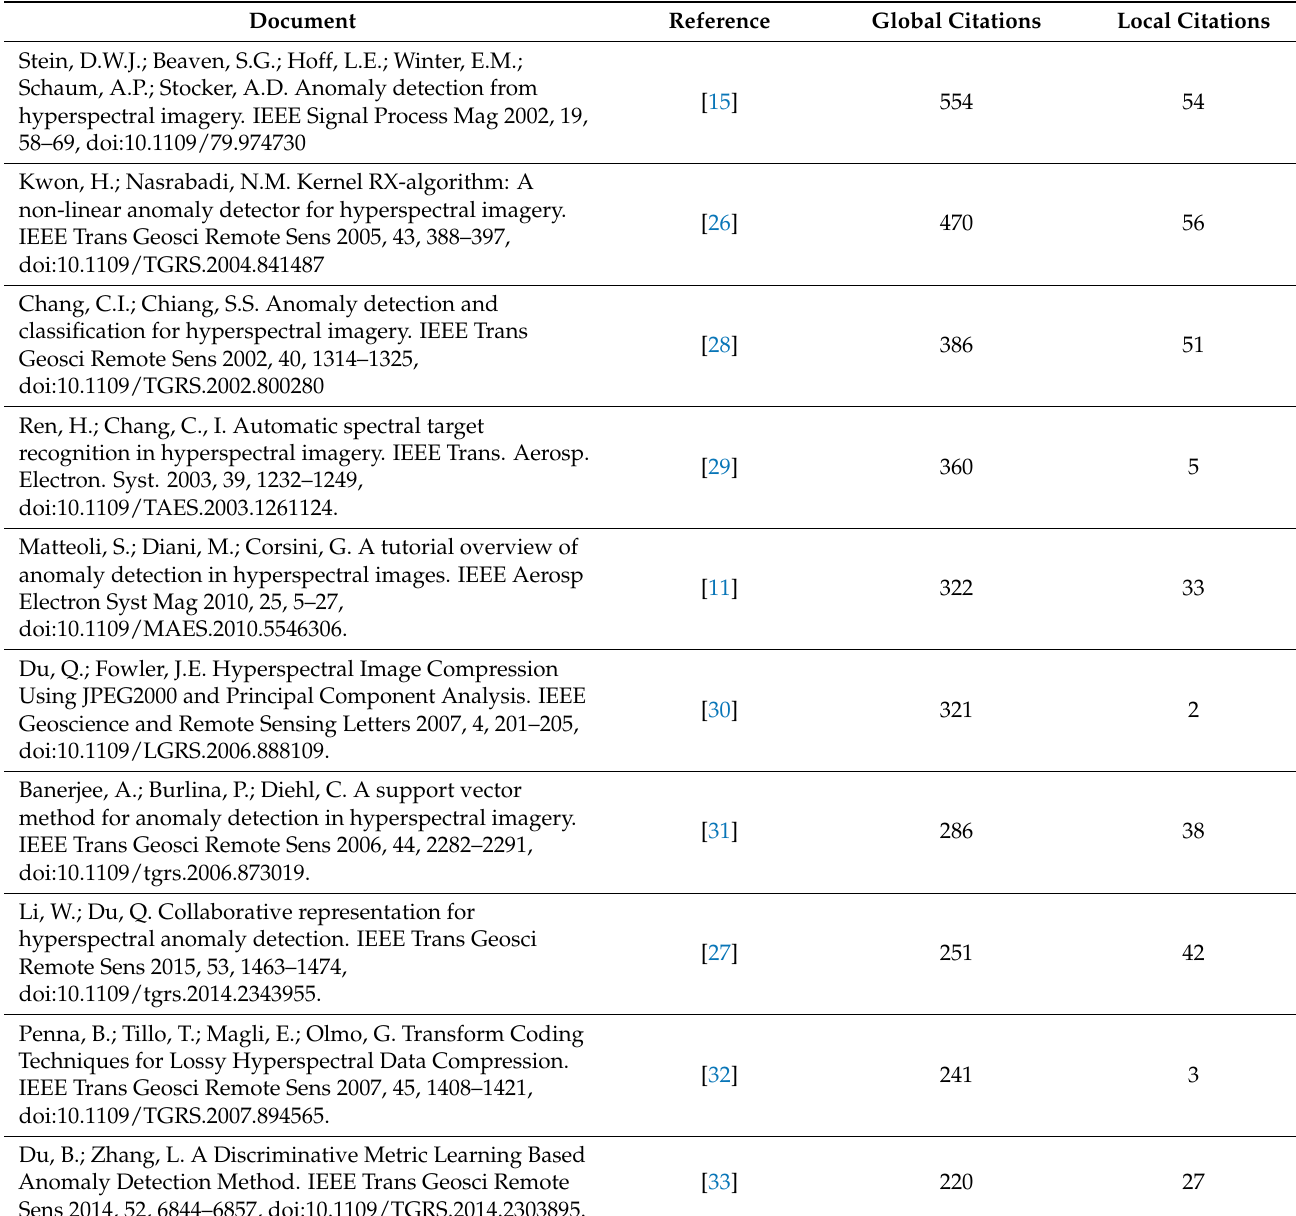
Table 4. The top 10 documents with the highest number of global